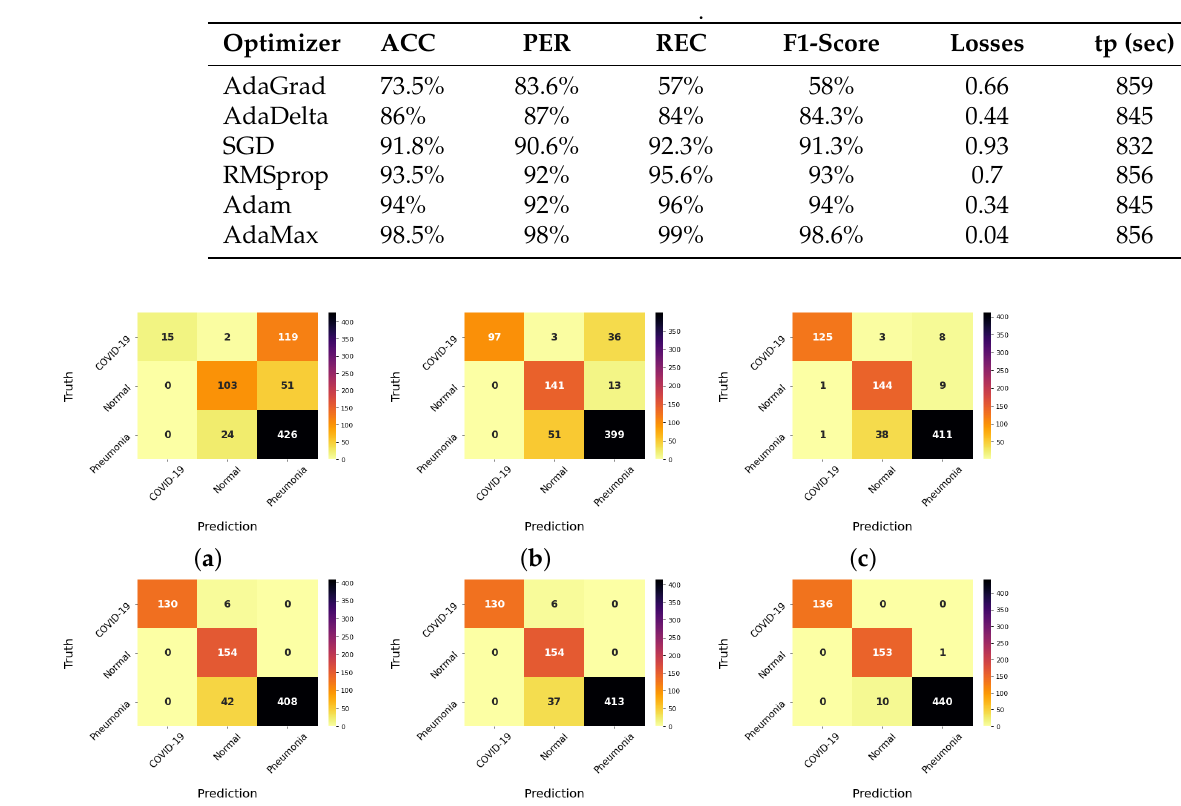
Figure 6. ROC curves of the proposed model with different optimizers using the LeakyReLU activation function set at ( α = 0.1). ( a ) AdaGrad, ( b ) AdaDelta, ( c ) SGD, ( d ) Adam, ( e ) AdaMax, and ( f ) RMSprop. Table 4. Overall evaluation of the proposed model with different optimizers and ELU activation function ( α = 0.2)